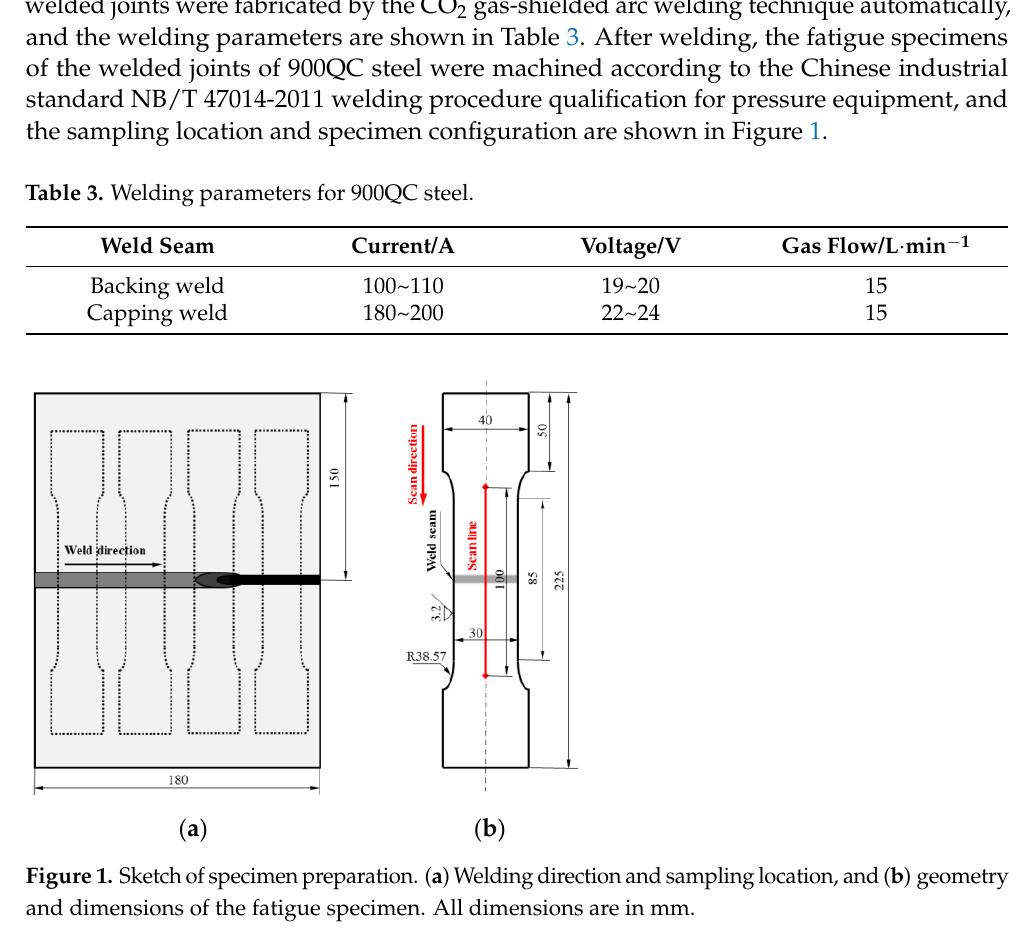
Table 3. Welding parameters for 900QC steel.